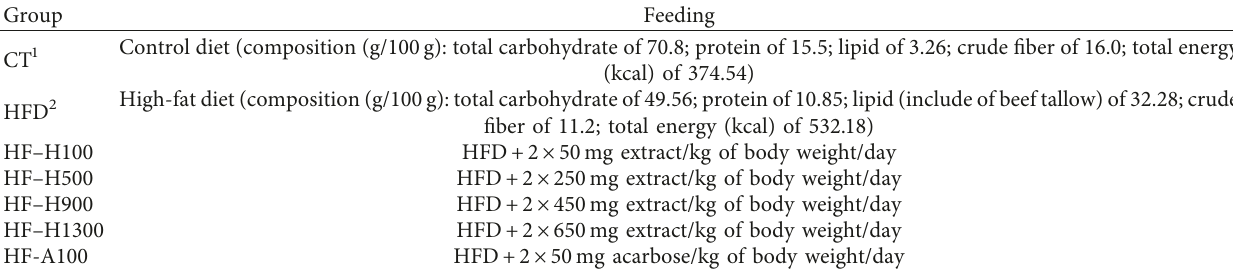
Table 1: Diets of tested mice. Group